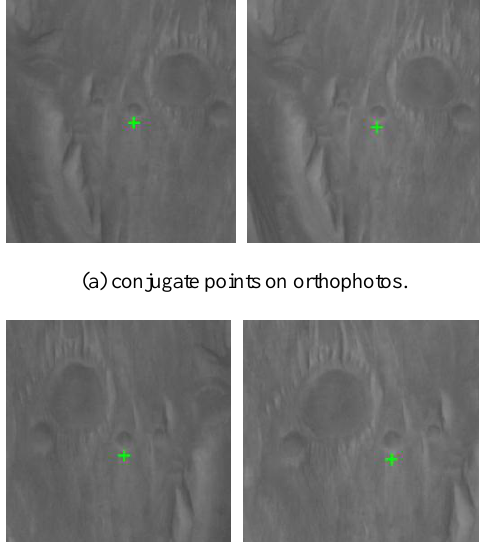
Figure 4. Comparison between HRSC Level-2 images and Level-3 images.